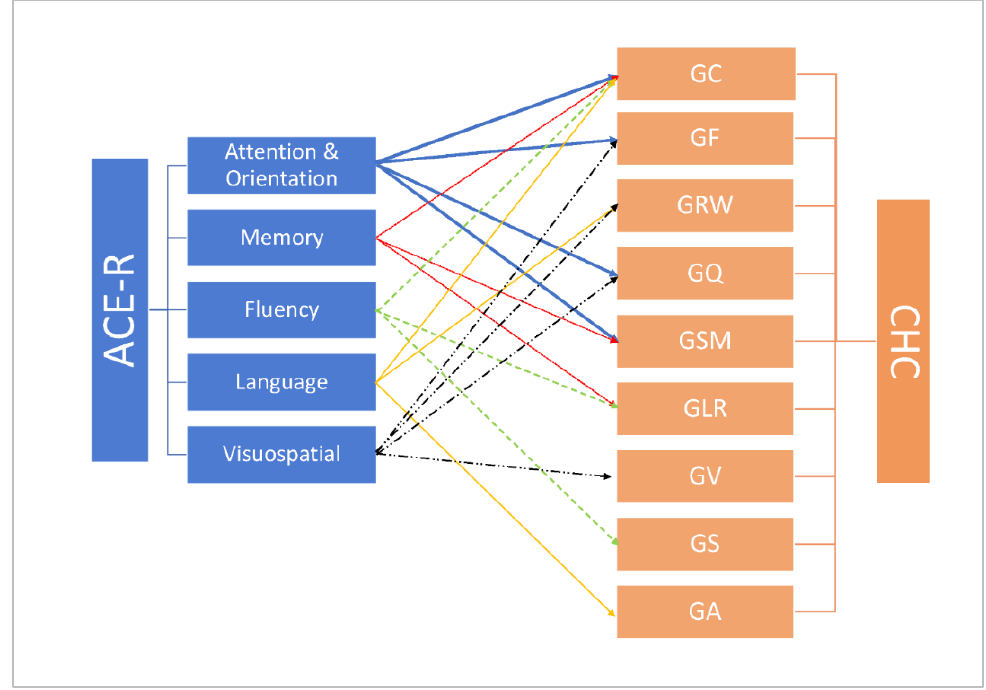
Figure 2. Proposal of the relationship between the Addenbrooke’s cognitive test and the Cattell – Horn – Carroll theory of cognitive skills.